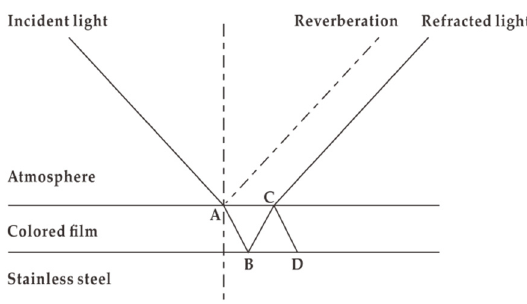
Figure 10. Schematic diagram of coloring principle.